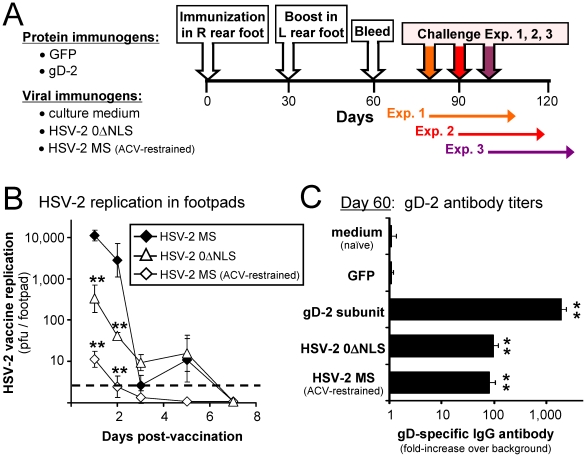
Immunization with HSV-2 0ΔNLS, gD-2, or control immunogens.(A) Design of vaccine-challenge experiments. Protein-immunized mice were injected in their right, rear footpads on Day 0 with 10 µg monophosphoryl lipid A, 2.5 µg gD-2 or GFP, and alum (n = 40 per group). On Day 30, mice received an equivalent immunization in their left, rear footpads. Virus-immunized mice received injections on Days 0 and 30 of culture medium (mock), 1×106 pfu of HSV-2 0ΔNLS, or 1×106 pfu of HSV-2 MS (n = 40 per group). Mice immunized with HSV-2 MS received 1 mg/ml acyclovir in drinking water from Days −1 to +20 p.i. On Day 60, blood was harvested from all mice, and on Days 80, 90, or 100, mice were challenged with wild-type HSV-2 MS. (B) HSV-2 replication in mouse footpads. In a parallel experiment, mice were footpad-injected with 1×106 pfu of HSV-2 MS in the presence or absence of oral acyclovir (ACV) or 1×106 pfu of HSV-2 0ΔNLS. On Days 1, 2, and 3 p.i., footpad titers of infectious HSV-2 were determined in n = 8 mice per group; on days 5 and 7 p.i., footpad titers were determined in n = 4 mice per group. All datum points represent mean ± sem pfu per footpad. A double asterisk (**) denotes p<0.001 that viral titers per footpad were the same as HSV-2 MS-inoculated mice not treated with acyclovir. (C) Mean ± sem relative abundance of gD-2 specific IgG antibody in mouse serum on Day 60 p.i., as determined by ELISA on 1∶100 dilutions of mouse serum (n = 30 per group). Relative units of IgG abundance are expressed as “fold-increase above background,” as determined relative to a 0.33-log dilution series of high titer anti-HSV-2 antiserum that provided the standard curve that defined the quantitative relationship between anti-gD-2 IgG antibody abundance and colorimetric development. A double asterisk (**) denotes p<0.001 that gD-2-antibody levels were equivalent to naïve (medium-treated) mice, as determined by one-way ANOVA and Tukey's post hoc t-test.